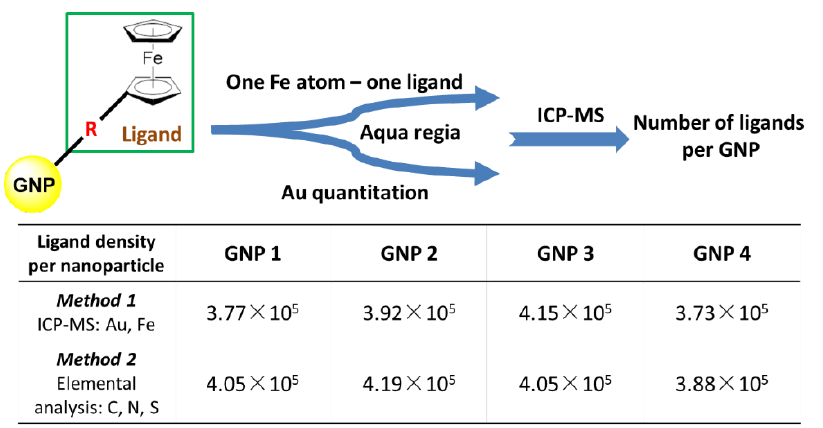
Figure 4. One-step determination of ligand loading on GNPs. The concentration of GNP was determined by the Au, and the concentration of ligand was determined by the Fe. Both determined using ICP-MS.